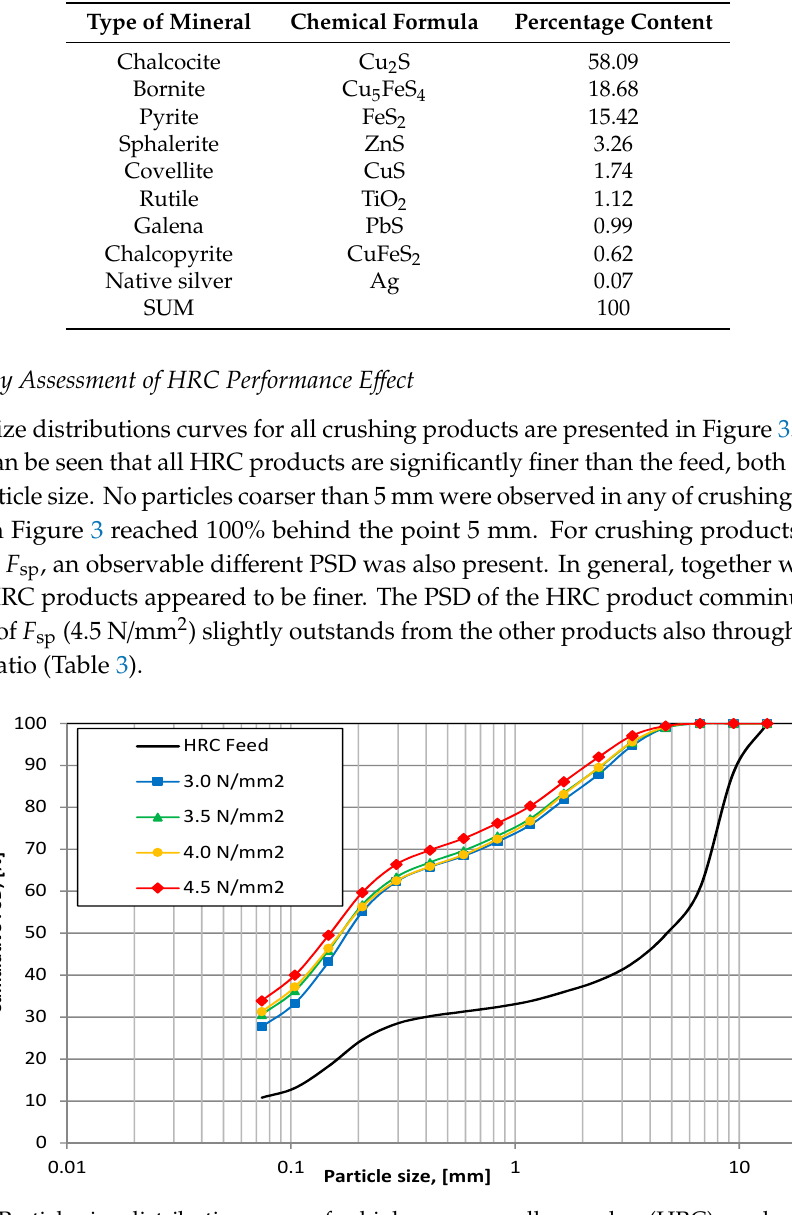
Table 4. Values of 50%, 80% and 95% reduction ratios ( S 50 , S 80 and S 95 ) for high-pressure roller crusher (HRC) crushing products.